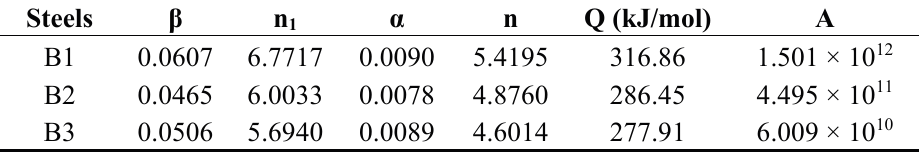
Figure 8. Relationship between [sinh(  p )] n and Z. Table 2. The parameters in the hot deformation constitutive